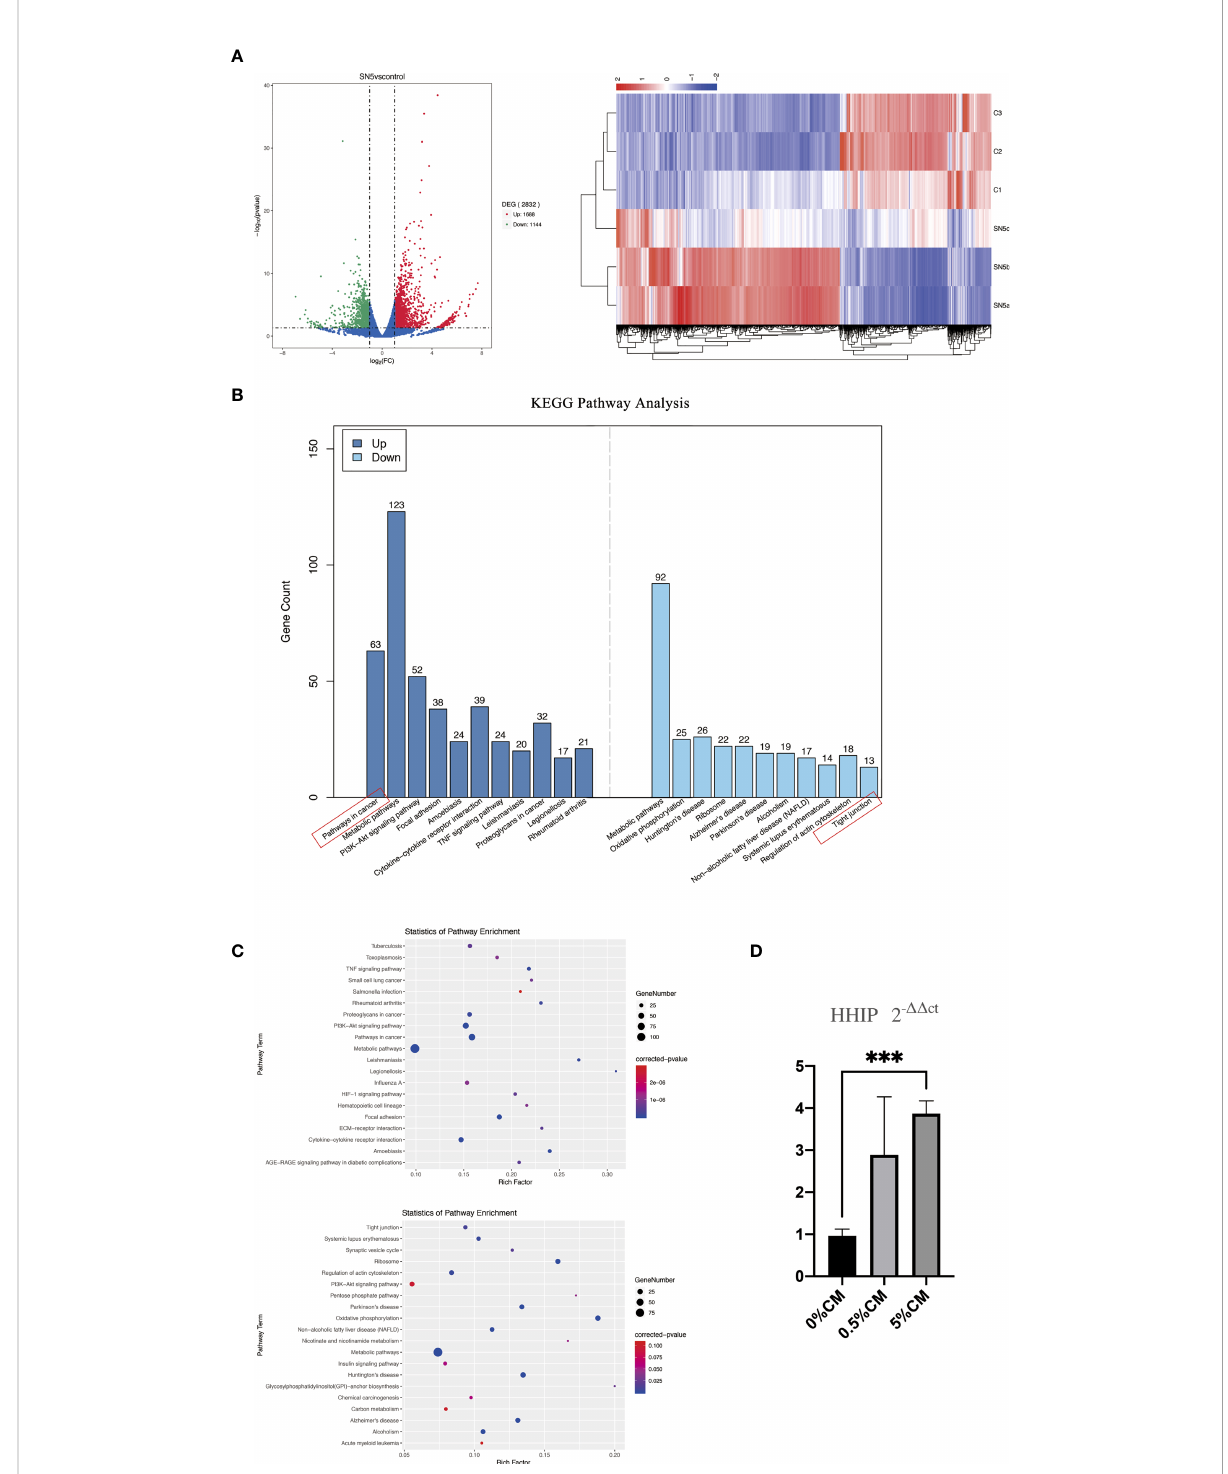
FIGURE 3 Comparison of the transcriptome pro fi les of cultured esophagi from 0% CM and 5% CM groups. (A) Volcano plot presenting the number, fold change, and statistical signi fi cance of DEGs and the cluster analysis of DEGs. Rows represent samples, and columns represent genes. (B) Up- and down-regulated pathways according to KEGG pathway analysis. (C) Numbers of DEGs and corresponding P values in terms related to up- and down-regulated pathways. (D) Differences in HHIP expression among 0% CM, 0.5% CM and 5% CM groups were determined by RT-qPCR. *** P <